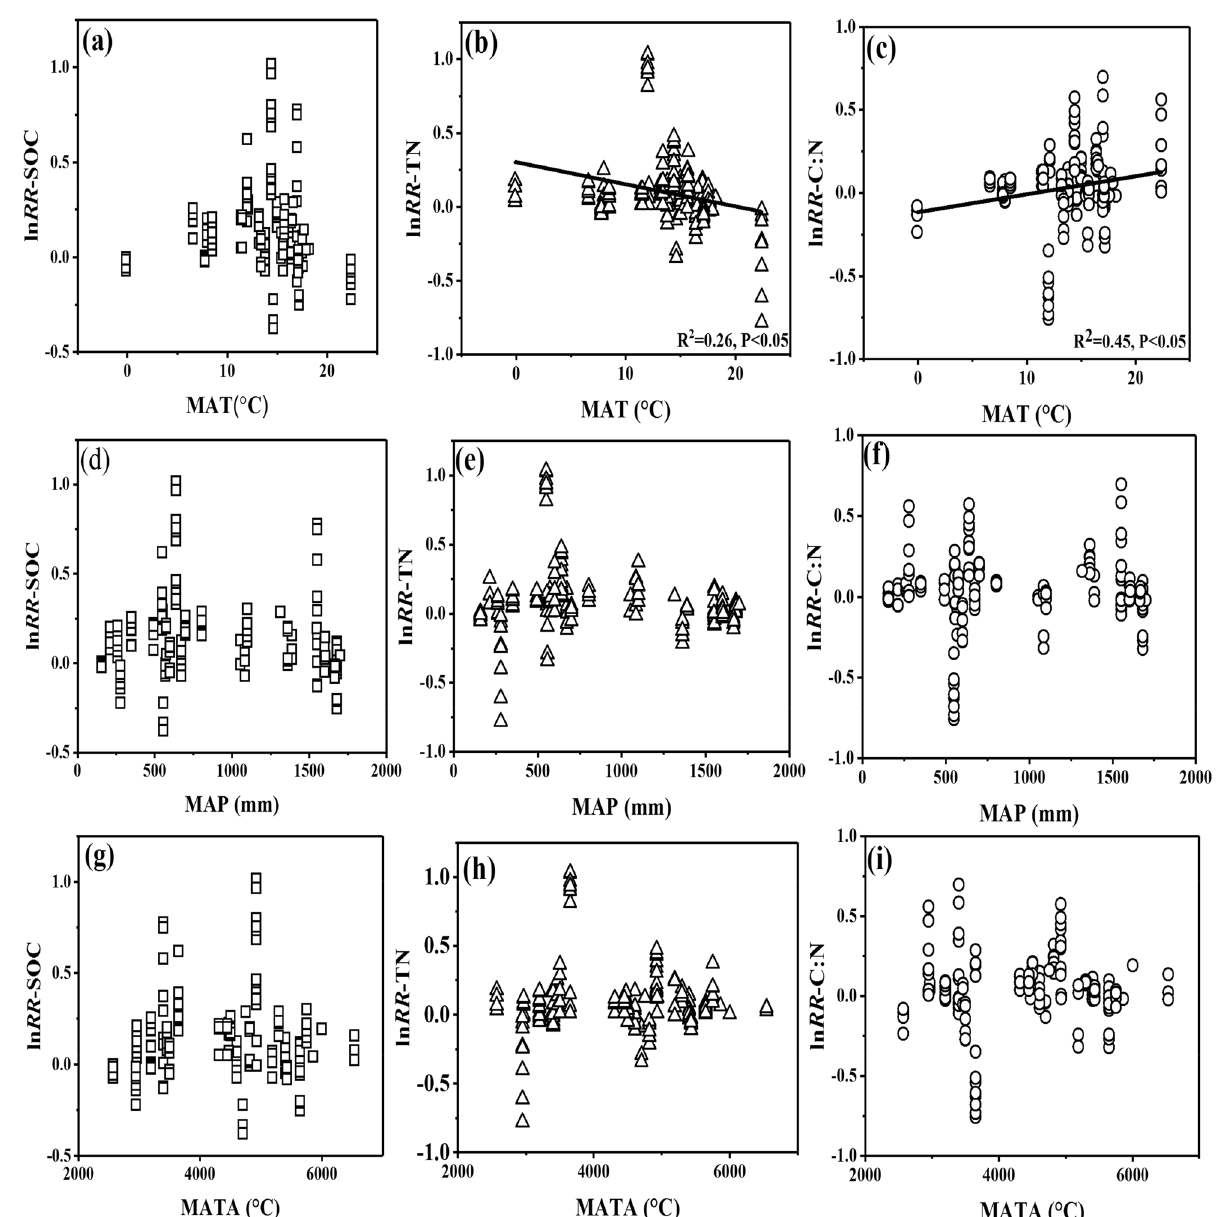
Figure 4. Relationship between mean annual temperature (MAT), mean annual precipitation (MAP), accumulated temperature above 10 °C (MATA) and the natural logarithm of the response ratio (lnRR) of soil organic carbon (SOC), total nitrogen (TN), and the ratio of SOC to TN (C:N). The black solid line shows the relationship between the lnRR of SOC, TN, C:N and environmental variables of all database of chemical nitrogen fertilizers with organic fertilizers